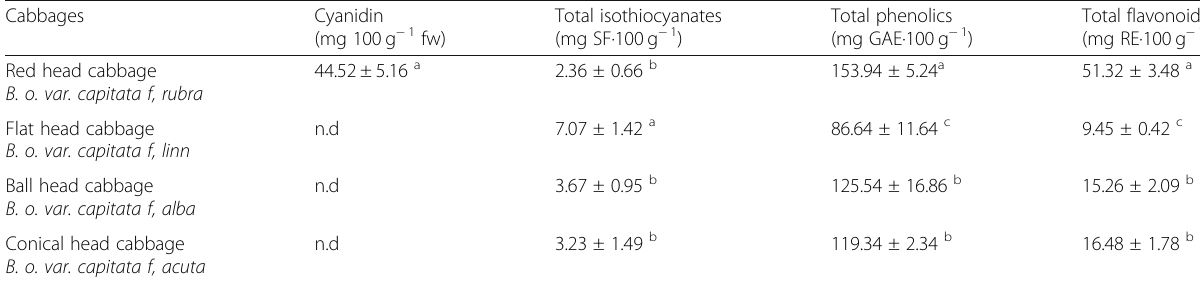
Table 3 The contents of anthocyanidins, isothiocyanates, phenolics and flavonoids in cabbages Cabbages